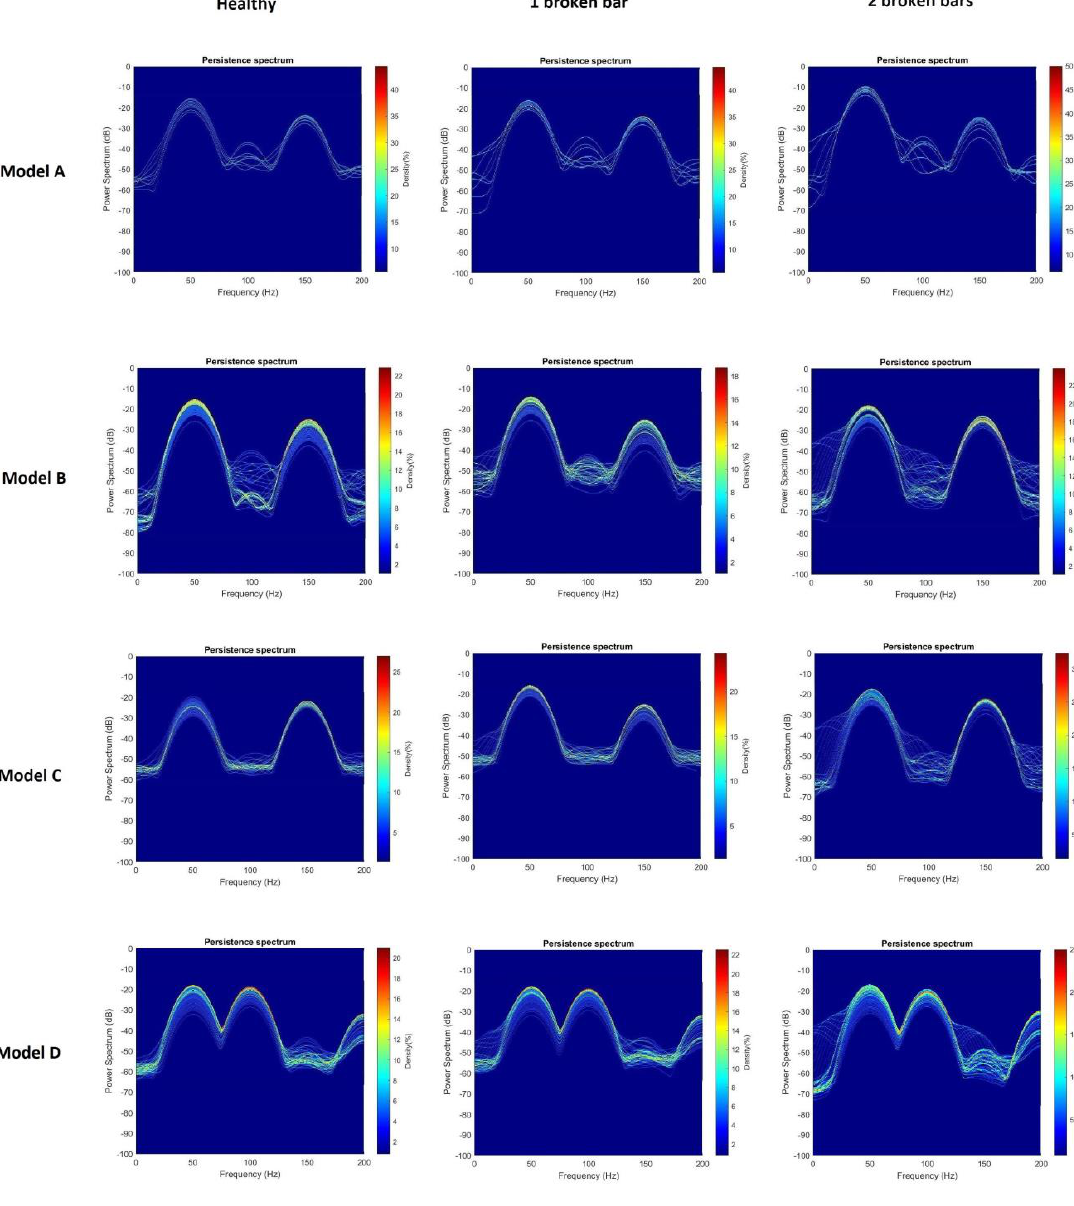
Figure 13. Comparison of Persistence Spectrum images for the three rotor health cases, for each model of soft starter.